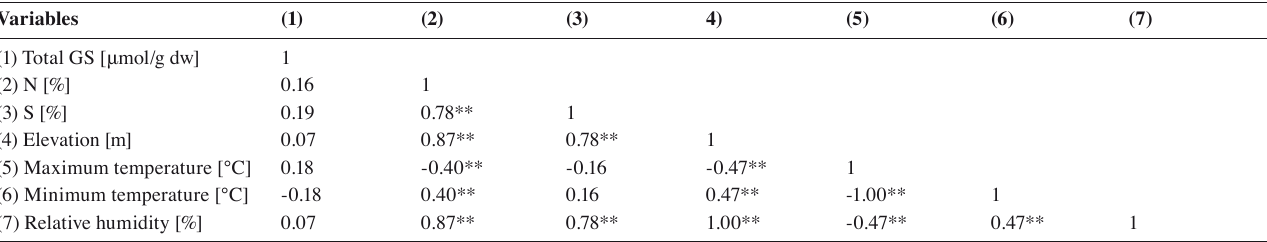
Tab. 8: Spearman’s correlation analysis between the total glucosinolate (GS) content of the leaves of the cultivated Moringa oleifera accessions, and the local conditions of the three experimental fields in the three agro-ecological zones.